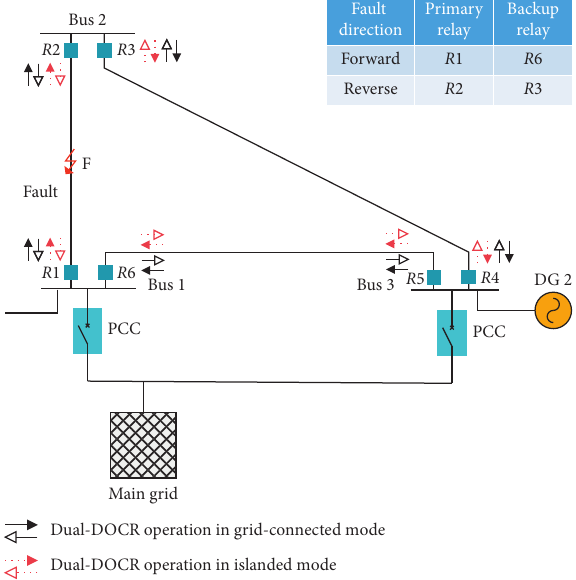
Figure 4: Operation of dual-DOCRs with the quaternary pro- tection scheme.